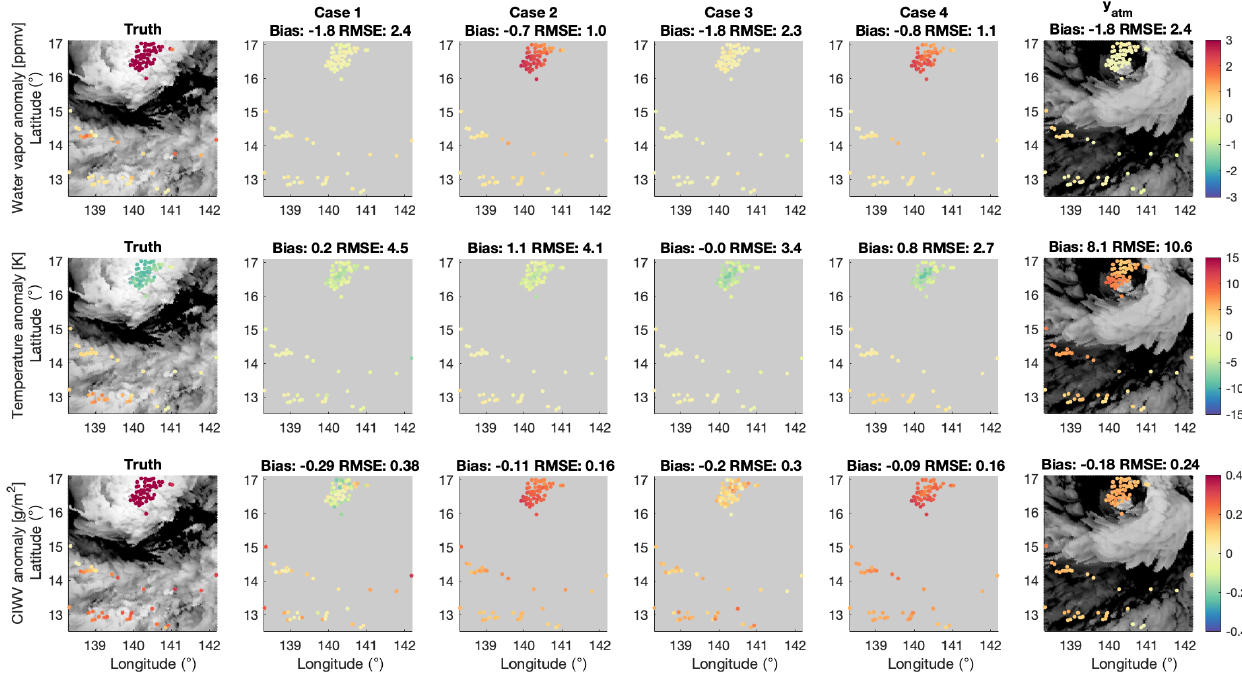
Figure 6. Horizontal distributions of the anomalies (defined as the deviation from x 0 ) in water vapor (in ppmv, upper panels), temperature (in K, middle panels) at 81hPa, and column integrated water vapor between 110 and 70hPa (in gm − 2 , lower panels). The true states are shown in the first column, with the BT 1231 distribution shown in the background of each panel via gray shading. The second to fifth columns show retrieved results for the four retrieval strategy cases described in Table 1. The sixth column shows the distribution of the additional observation vector, y atm , incorporated into the retrievals in Cases 2 and 4. This additional atmospheric constraint ( y atm ) is taken from the model fields 810min after the initial simulation time